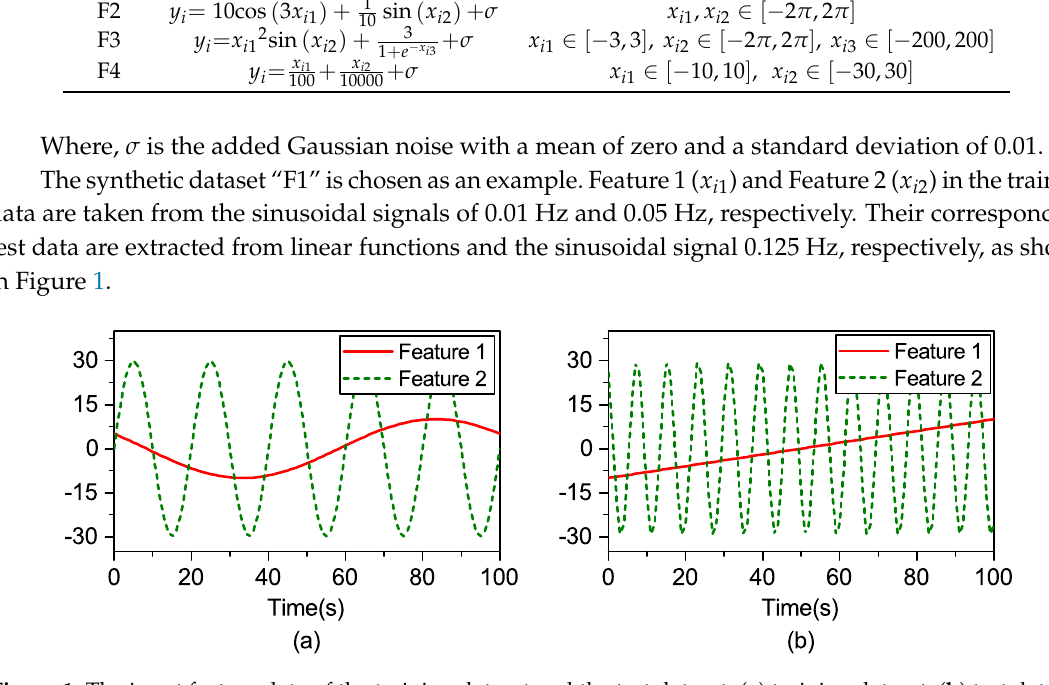
Figure 1. The input feature data of the training dataset and the test dataset: ( a ) training dataset; ( b ) test dataset.